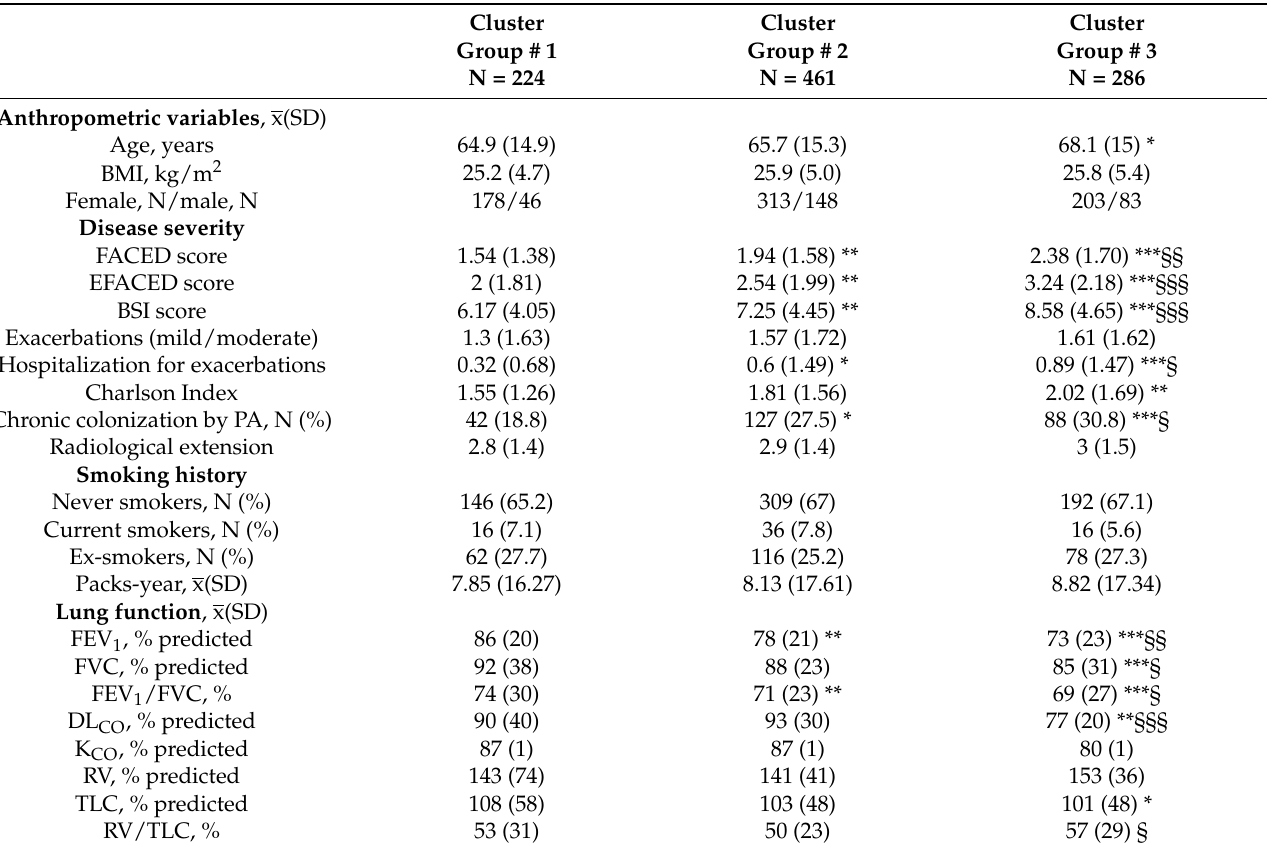
Table 3. General characteristics in the two clusters of bronchiectasis patients excluding those with COPD. Cluster Cluster Cluster Group # 1 Group # 2 Group # 3 N = 224 N = 461 N =